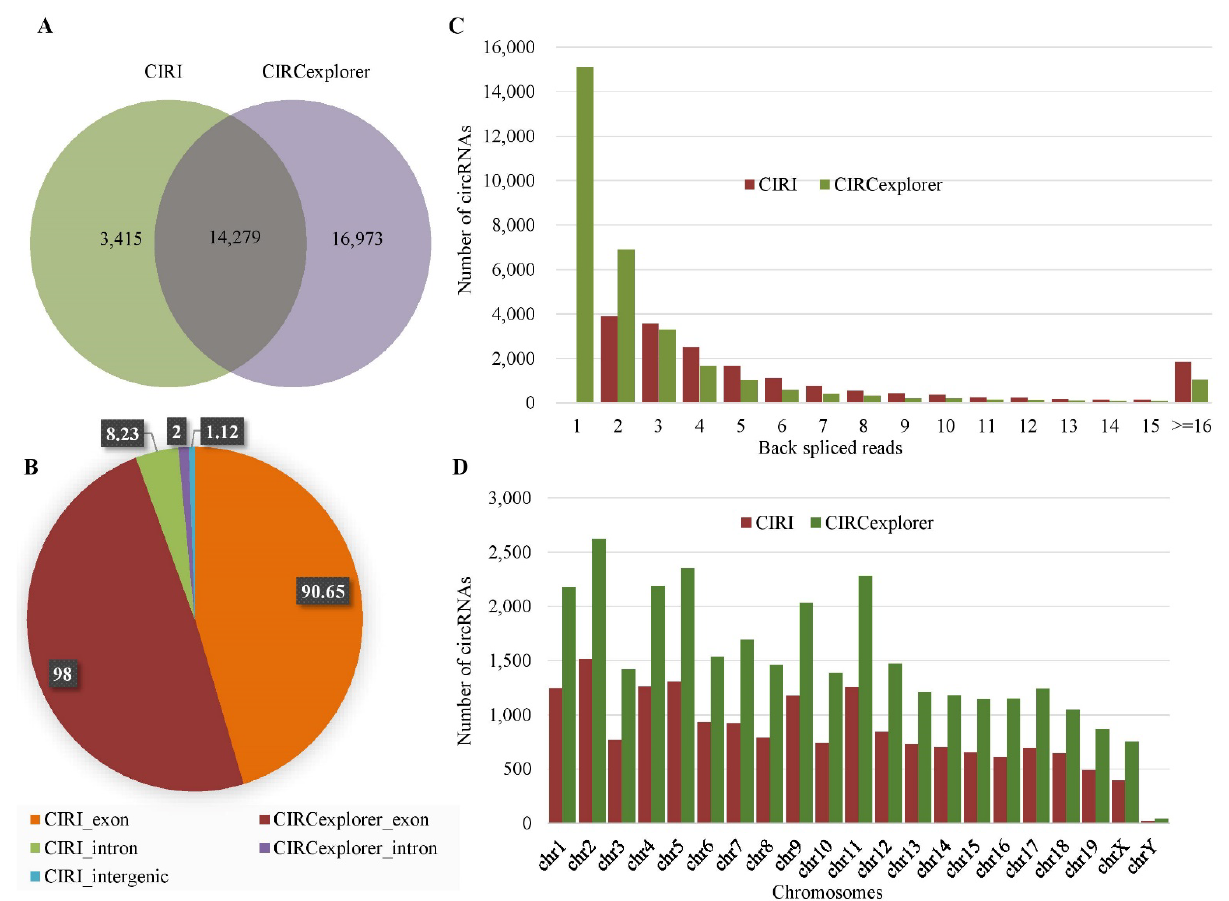
Figure 2. Expression profile of circRNAs in mouse data. ( A ) Venn-diagram of the circRNAs identified by CIRI and CIRCexplorer. ( B ) Distribution of the genomic origin of the circRNAs (%). ( C ) Distribution of the number of back-spliced reads spanning the circRNAs. ( D ) Chromosome distribution of the identified circRNAs.